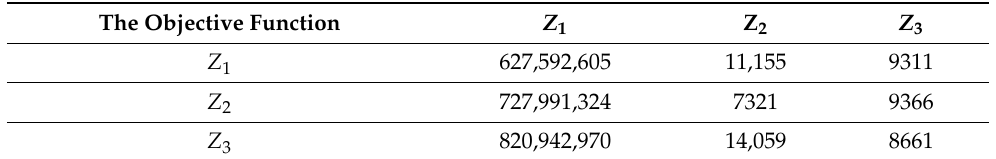
Table 10. Pay off table of